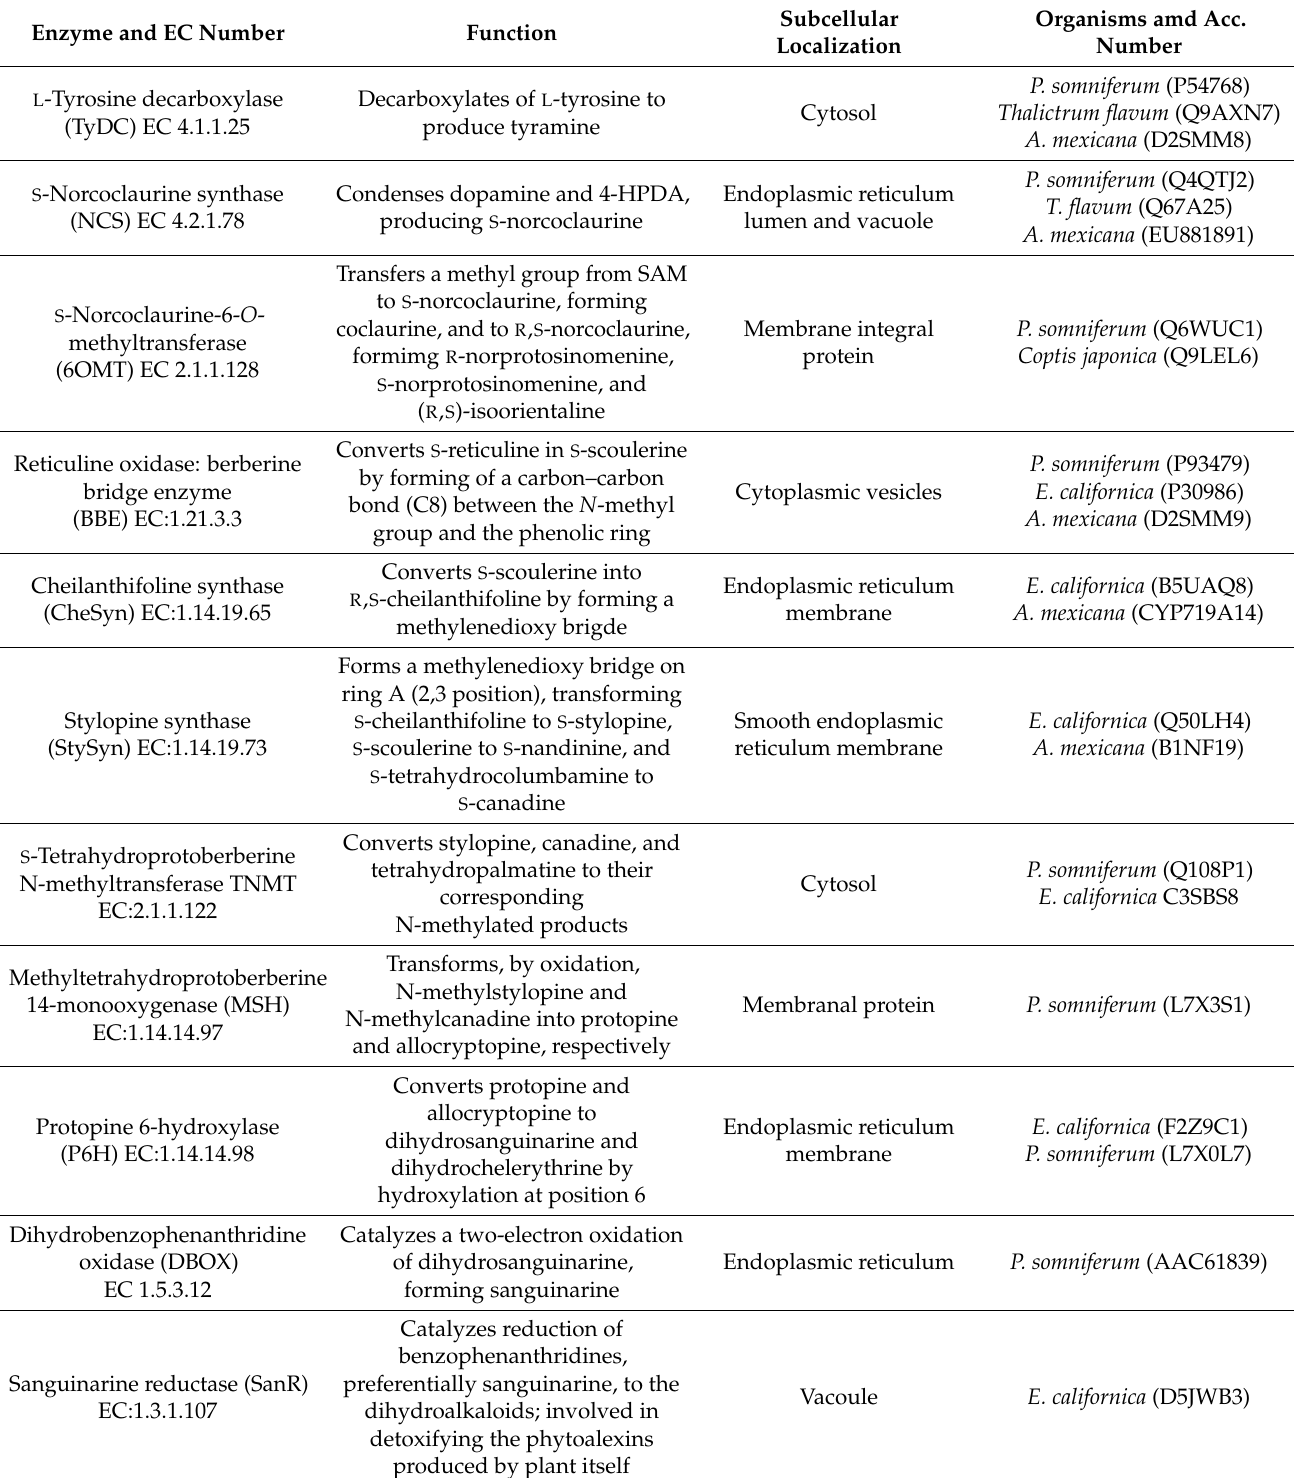
Table 2. Enzymes involved in sanguinarine biosynthesis, describing reaction catalyzed and subcellu- lar localization. Data were collected from UniProt Beta (https://beta.uniprot.org/ (accessed on 12 December